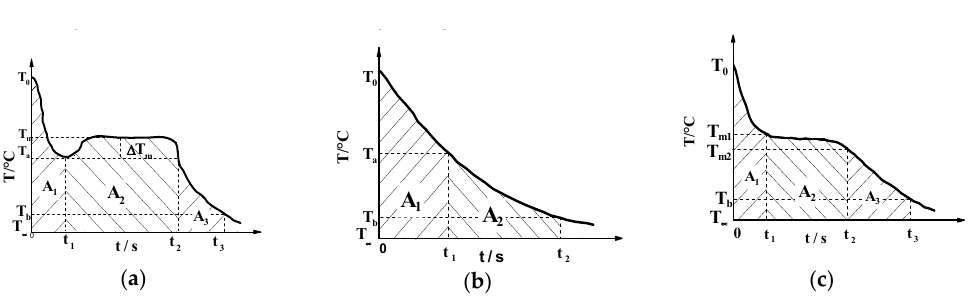
Figure 5. Cooling curve of phase change material (PCM) with ( a ) undercooling, ( b ) water, and ( c ) without undercooling.